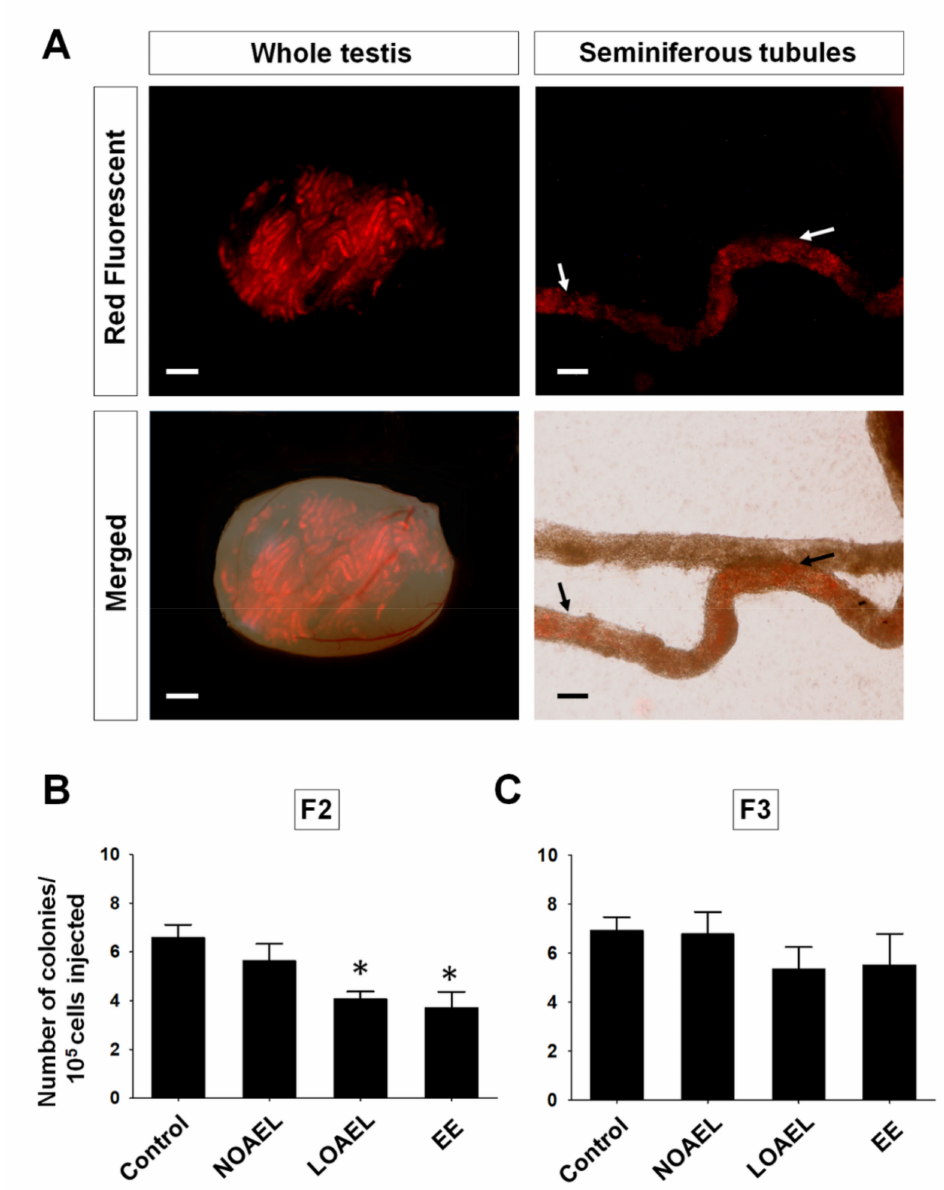
Figure 7. Germ cell transplantation into recipient mice and analysis of recipient testes. Germ cell transplantation was conducted to evaluate the bisphenol-A-induced e ff ect on the stemness properties of spermatogonial stem cells (SSCs). Donor germ cells collected from F2 and F3 generations were stained with PKH26 (red fluorescent). ( A ) Images of the left panel show fluorescent expression of seminiferous tubules (STs) and the merged image of STs inside the recipient testis of transplanted germ cells for F2 generation (scale bar = 2 mm). The right panel shows a fluorescent and merged view of the colonization of donor germ cells inside the recipient ST. White and black arrows are showing the places of colonization. Scale bar = 200 µ m. The bar graph represents the number of donor cell-derived colonies per 10 5 transplanted germ cells for ( B ) F2 and ( C ) F3 generations. For the F2 generation, the total numbers of mice / testes analyzed were 9 / 15, 9 / 16, 10 / 18, and 8 / 16 for the control, no-observed-adverse-e ff ect-level (NOAEL), lowest-observed-adverse-e ff ect level (LOAEL), and ethinylestradiol (EE), respectively. For the F3 generation, the total numbers of mice / testes analyzed were 8 / 15, 9 / 17, 9 / 16, and 8 / 15 for the control, NOAEL, LOAEL, and EE, respectively. The asterisk (*) indicates significant di ff erences (* p < 0.05 ) compared with the